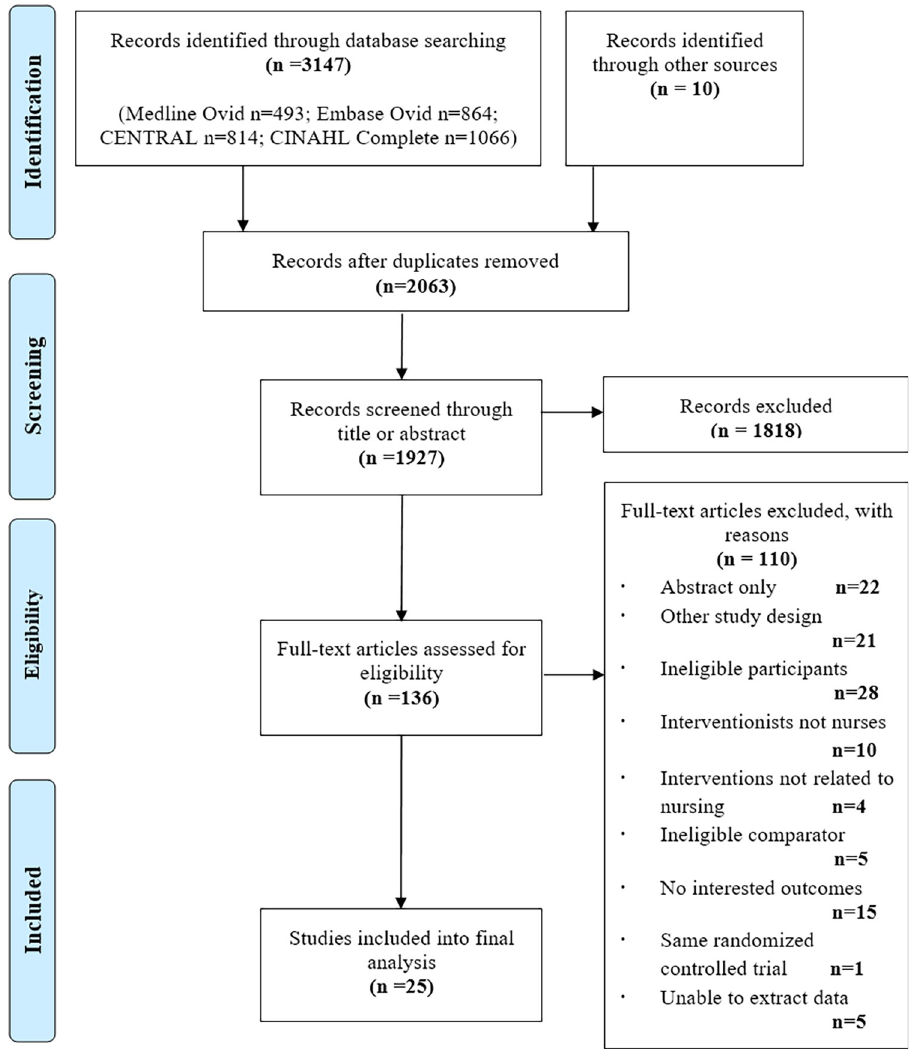
Fig 1. Flowchart illustrating the search strategy (limit time 2000–2020). From : Moher D, Liberati A, Tetzlaff J, Altman DG, The PRISMA Group (2009). Preferred Reporting Items for Systematic Reviews and Meta-Analyses: The PRISMA Statement. PLOS Med 6(7): e1000097. doi:10.1371/journal.pmed1000097.